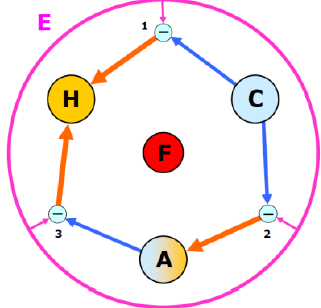
Fig. 7. – Negative thermodynamic cycles —compression